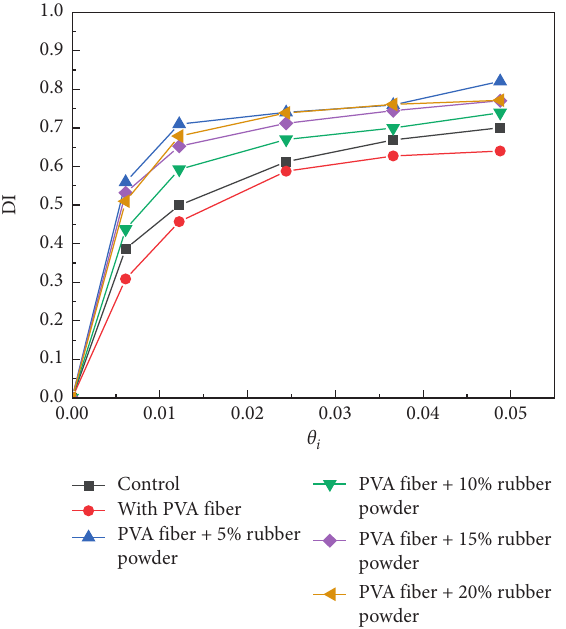
Figure 12: Relationship between damage index and displacement angle.